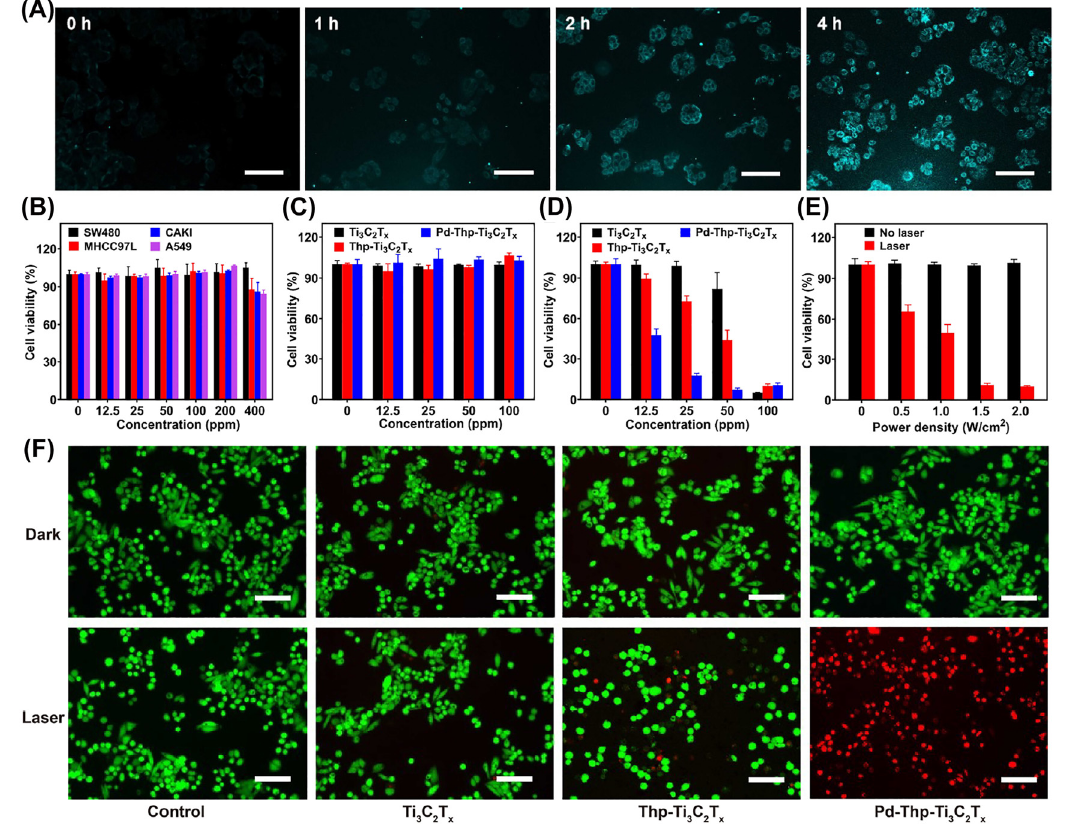
C T -Cy5.5 3 2 x C T with different 3 2 x